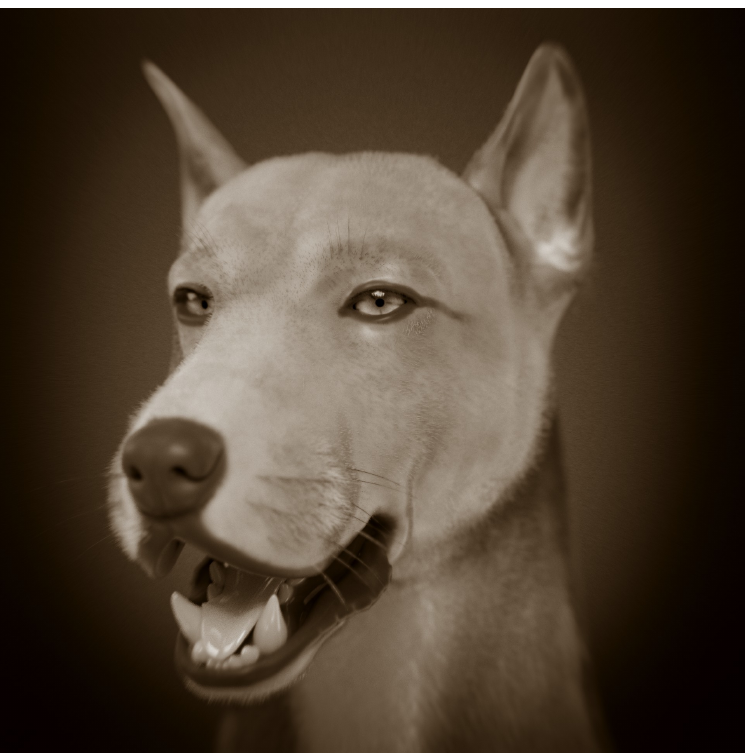
Figure 4. The picture of the Muge dog 3D model in sepia tones due to the lack of genetic information regarding its coat texture and color (CC BY-SA